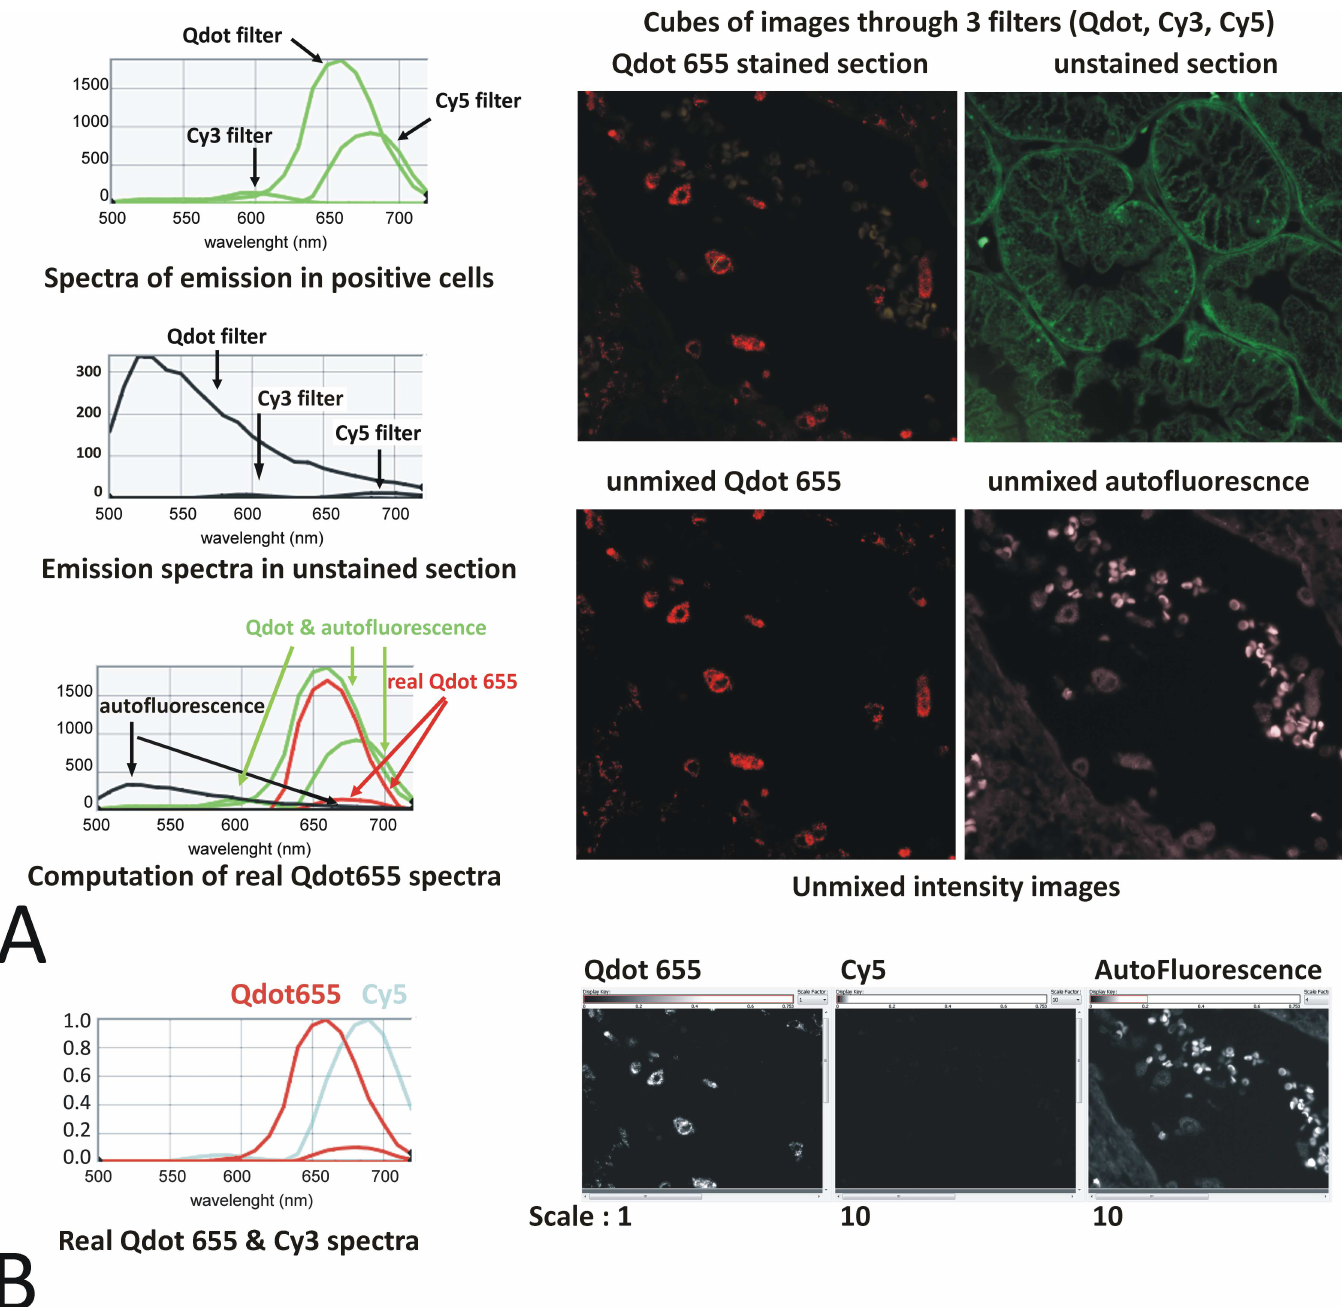
Fig 11. Qdot655 imagedunderQdot,Cy3 & Cy5 conditions. Evidenceof bleed throughin Cy3 filterand resolutionwithspectralunmixing. A: A Qdot655 single color immunofluorescence and an unstainedkidney sectionwere imagedwith LED single wave lengthsPE 4000 435, 550 & 635nmthrough the Qdot,Cy3 & Cy5 filterset respectively. The resultingcubes of imagesare shown in the top panel.The spectra of emission in the positive cells (Qdot655 + autofluorescence–green curves) and the autofluorescence (black curves)were obtained,and the real Qdot655was mathematically computed(redcurves) using the Nuance software[13]:A peak of emissionremainsin the real Qdot spectra corresponding to genuine bleed throughof Qdot 655 in the Cy5 filter. Note the presence of fluorescence in the Cy5 filtersuggestingbleed through(the curvehighs are dependent upon the exposure timeof the imageand thus do not reflectthe intensityof the fluorescence).The Nuance spectralanalysissoftwareuses the spectralinformation fromall 3 filtersused to unmix a real Qdot655 intensityimagefromthe autofluorescence (bottompanel). B: A Cy5 stainedsection was used to similarlycomputethe real Cy5 spectra when imagedthroughthe 3 filters(cyan curves).When this spectra, togetherwith the real Qdot655(red curve)& autofluorescence spectra are used to unmixed a Qdot655single stainedsection,appropriately, no fluorescence is assignedto Cy5: Spectralunmixingcan resolve the bleed throughthat a normal fluorescence systemwould not. Note the autofluorescence and Cy5 intensityimageshave been scaled up 10 fold to help visual assessment of the absence of fluorescence.